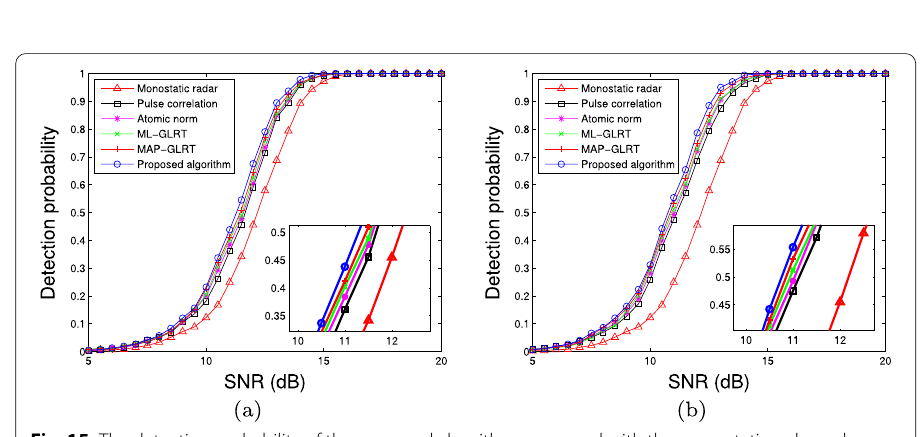
Fig. 15 The detection probability of the proposed algorithm compared with the monostatic radar, pulse correlation method, atomic norm optimization, ML-GLRT and MAP-GLRT a alignment by two radars b alignment by three